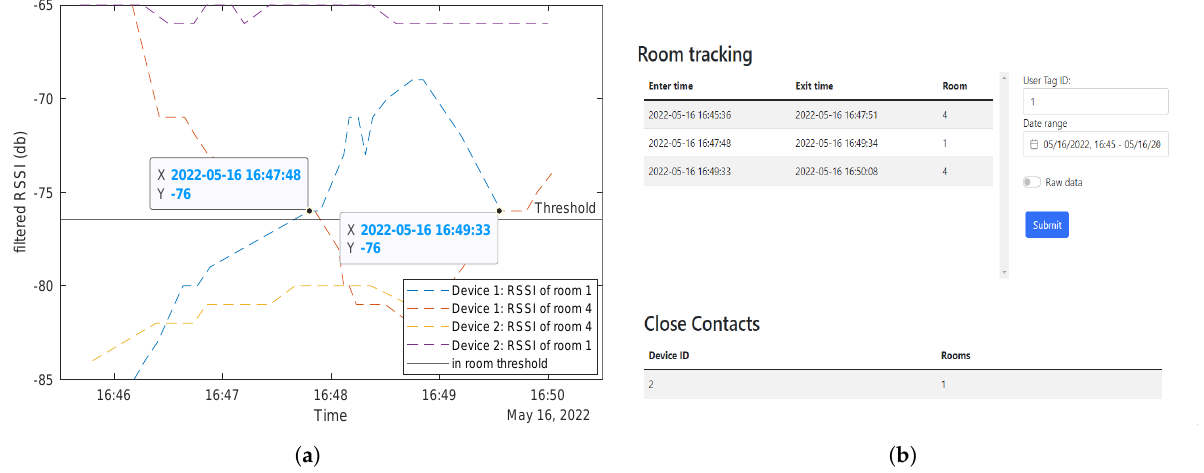
Figure 19. Close contact detection first test results: ( a ) RSSI values, ( b ) web app